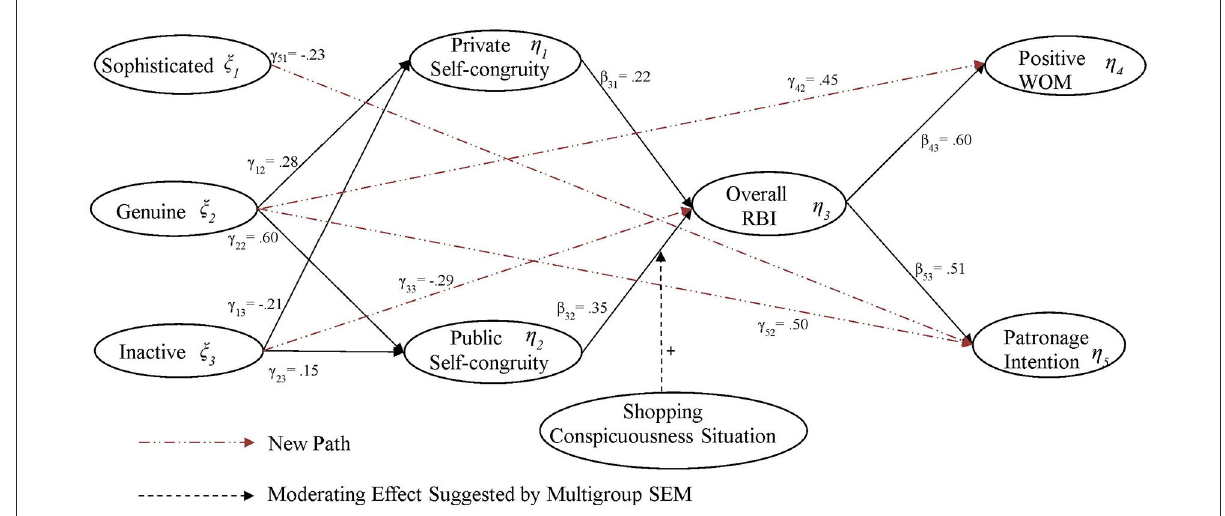
FIGURE1 Retailer brand personality-behavioral outcomes final structural model for department and discount retailer image